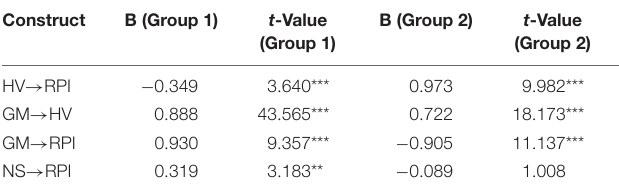
TABLE 10 | Results of hypothesis tests for segmented